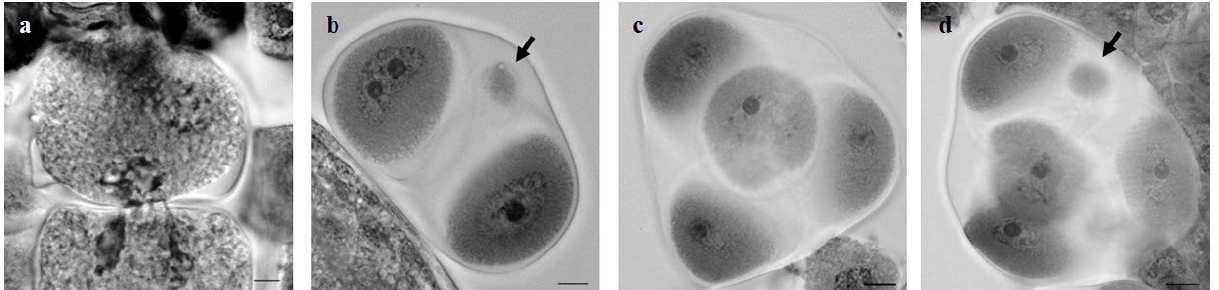
Fig. 2. Tetrad analysis of L. algarvense . a Cytoplasmatic bridges with chromosome passing (cytomixis); b Unbalanced triad (a micronucleus is arrowed); c Tetrad; d Polyad (a micronucleus is arrowed). Bars = 5 µm.